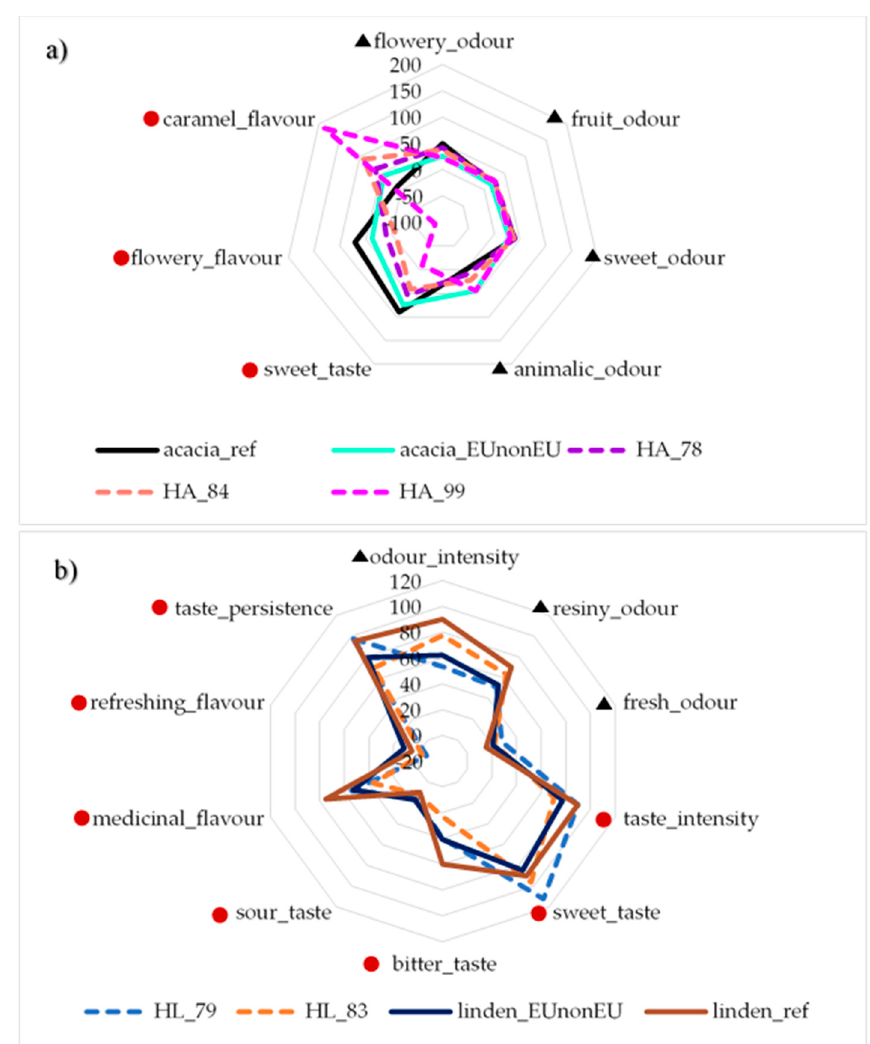
Figure 3. Results of the electronic nose LDA model for classification of authentic and adulterated acacia ( a ) (n= 127) and linden ( c ) (n= 94) honeys and models for independent prediction with EUnonEU blends for acacia ( b ) (n=127+35) and linden ( d ) (n= 94+21) honeys;  training,  validation and  independent prediction. predicted from the results of ET and